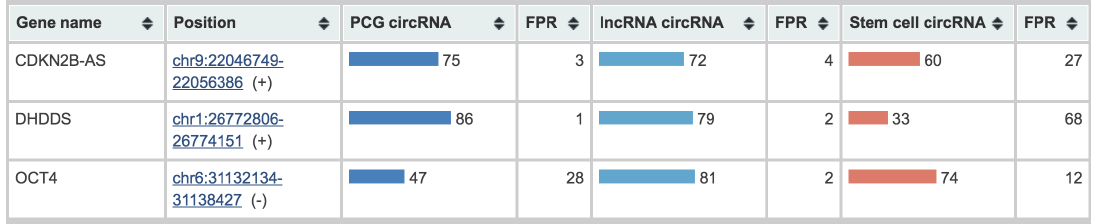
Figure 6. WebCircRNA. Example output for the lncRNA CDKN2B-AS and the two PCGs DHDDS and OCT4 is shown. We thus ignore the “PCG circRNA” score for CDKN2B-AS and the “lncRNAs circRNA” scores for DHDDS and OCT4. Because “stem cell circRNA” scores only apply to circRNAs, this too should be disregarded for OCT4, since it is not predicted to have a circRNA isoform. The respective “FPR” shows the estimated false positive rate of the corresponding methods. When submitting a BED file, the genomic context of any prediction can view in the UCSC browser via the link in the “Position”